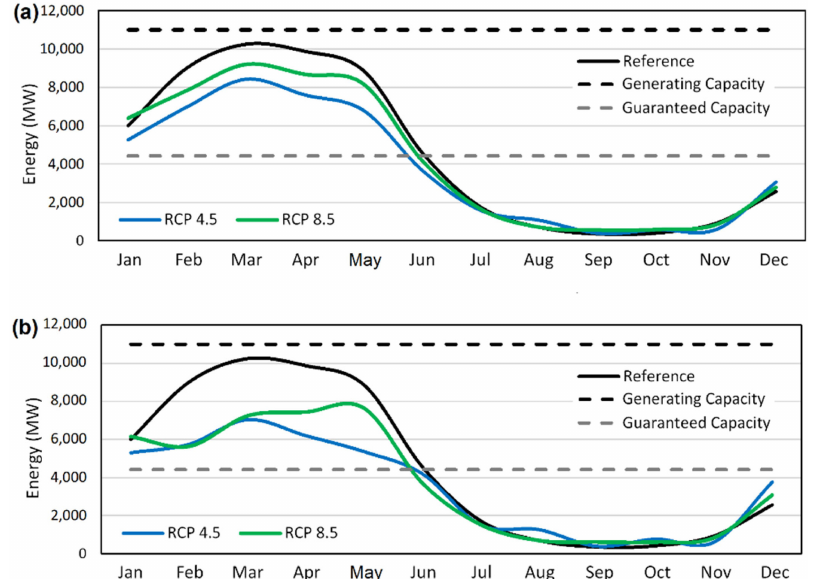
Figure 14. Estimates of the monthly mean generation potential at Belo Monte based on the flow rates observed in the reference period (1981–2010) and on the ones projected for the 2021–2050 ( a ) and 2051–2080 ( b ) periods, based on the RCP 4.5 (blue) and the RCP 8.5 (green)